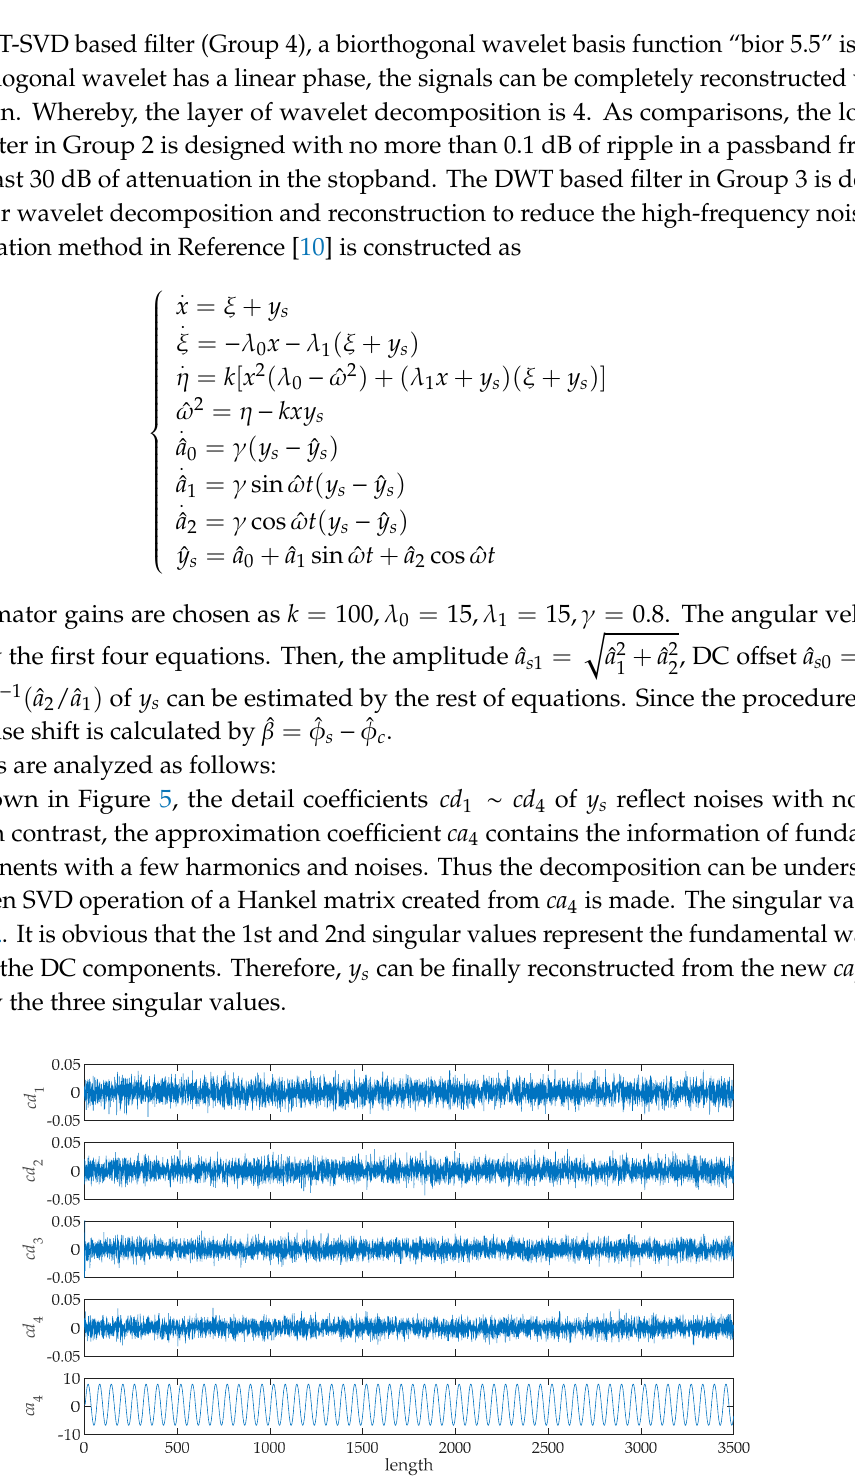
Figure 5. The first 3500 data of approximation coefficient and detail coefficients of